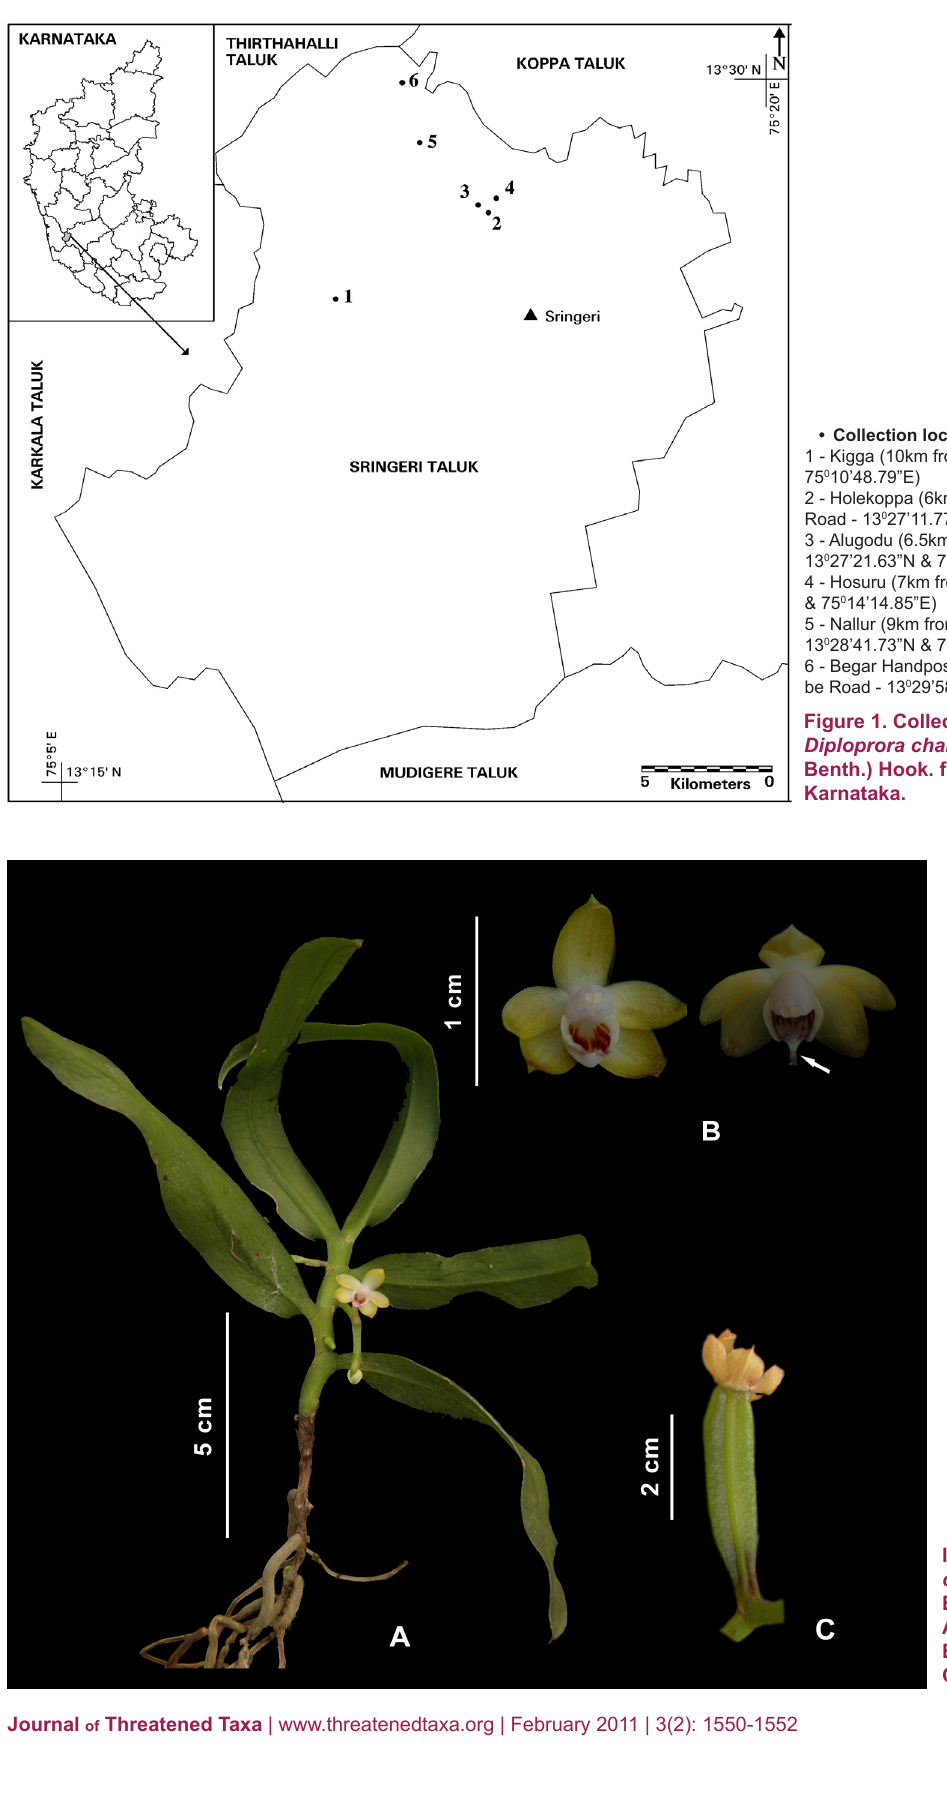
Image 1. Diploprora championii (Lindl. ex Benth.) Hook. f. A - plant habit; B - Single flower; C -